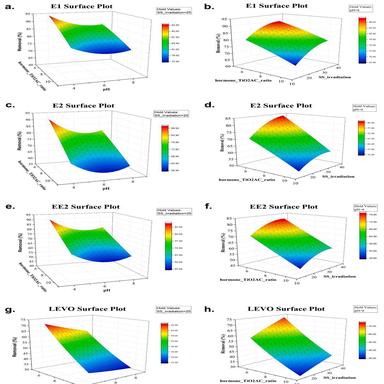
The 3D response surface plot. Interactions of (i) pH vs hormone concentration_TiO2-AC composite ratio; and (ii) hormone concentration_TiO2-AC ratio vs simulated solar light irradiation (SS_irradiation) and effects on the removal (%) of E1 (a and b), E2 (c and d), EE2 (e and f), and LEVO (g and h).